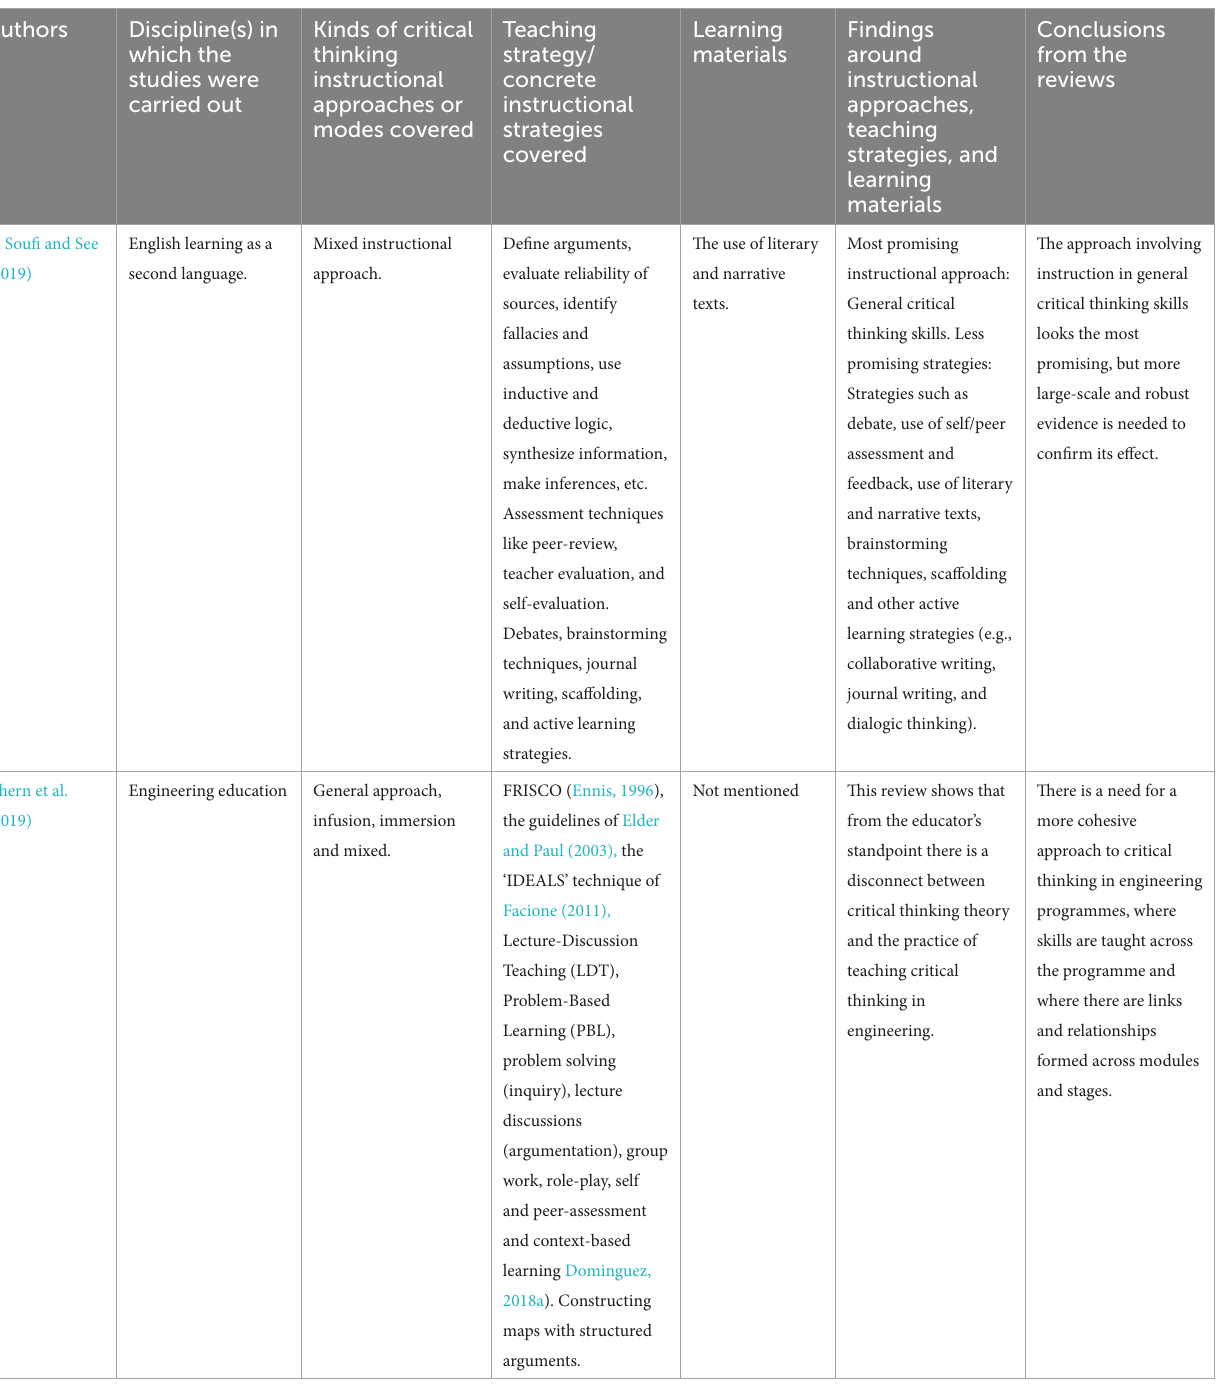
TABLE 6 Approaches and strategies applied for the development of critical thinking in HE from selected reviews.